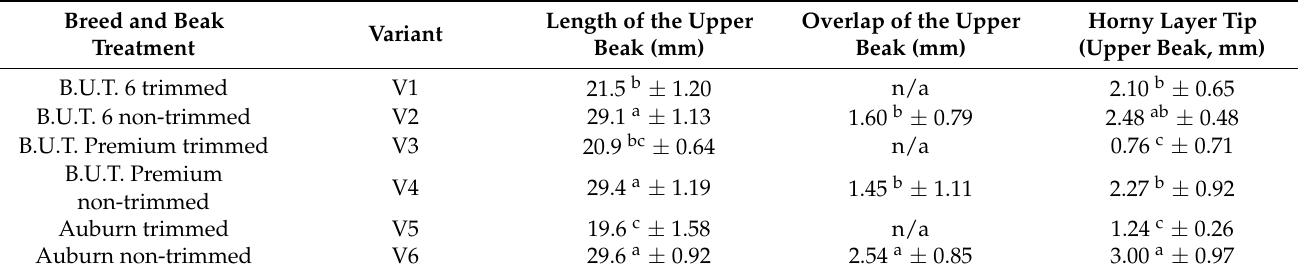
B.U.T. = British United Turkey; V = variant; different superscript lowercase letters within a column indicate a main effect ( p ≤ 0.05); n/a = not